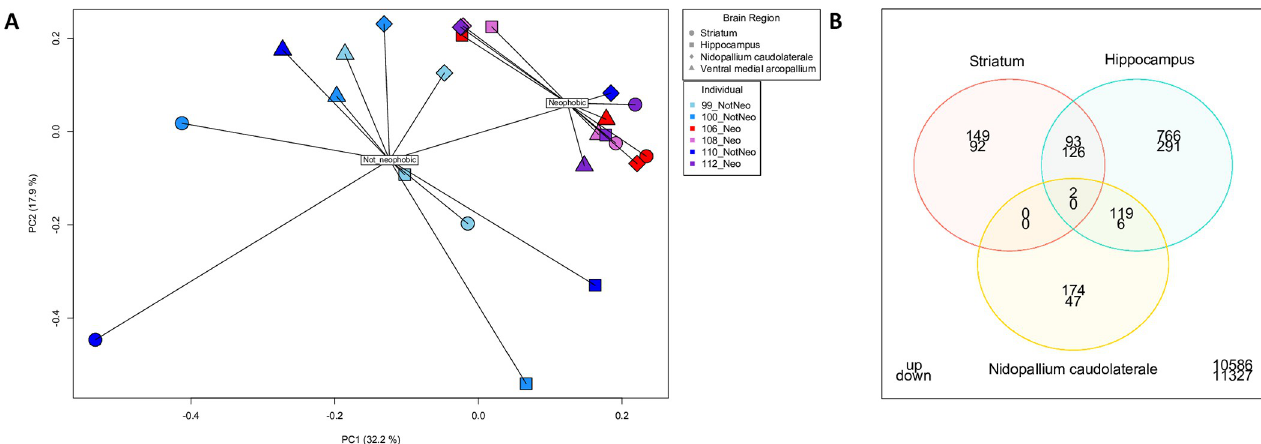
Fig 3. A) Distance-based Redundancy Analysis (dbRDA) spider plot of gene expression, split by brain region and phenotype. Each brain region is represented by a different shape, and phenotypes are represented by colors (blue shades: not neophobic or “NotNeo”, n = 3 and red shades: neophobic or “Neo”, n = 3). Results from permutational multivariate analysis of variance (PERMANOVA) are shown. B) Venn diagram of genes differentially expressed between neophobic and not neophobic individuals. This diagram highlights the minimal overlap among different brain regions in the identities of differentially expressed